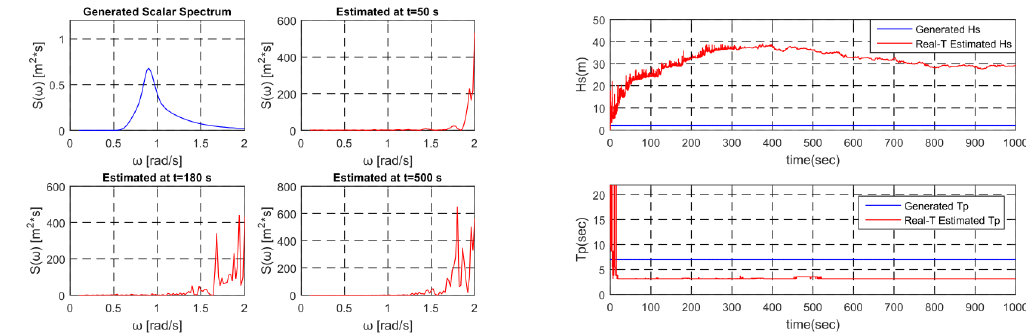
Figure 8. Generated and estimated spectrum / Evolution of parameters (Hs = 2 m, Tp = 7 s, Frequence: 0.1~2.0 rad /